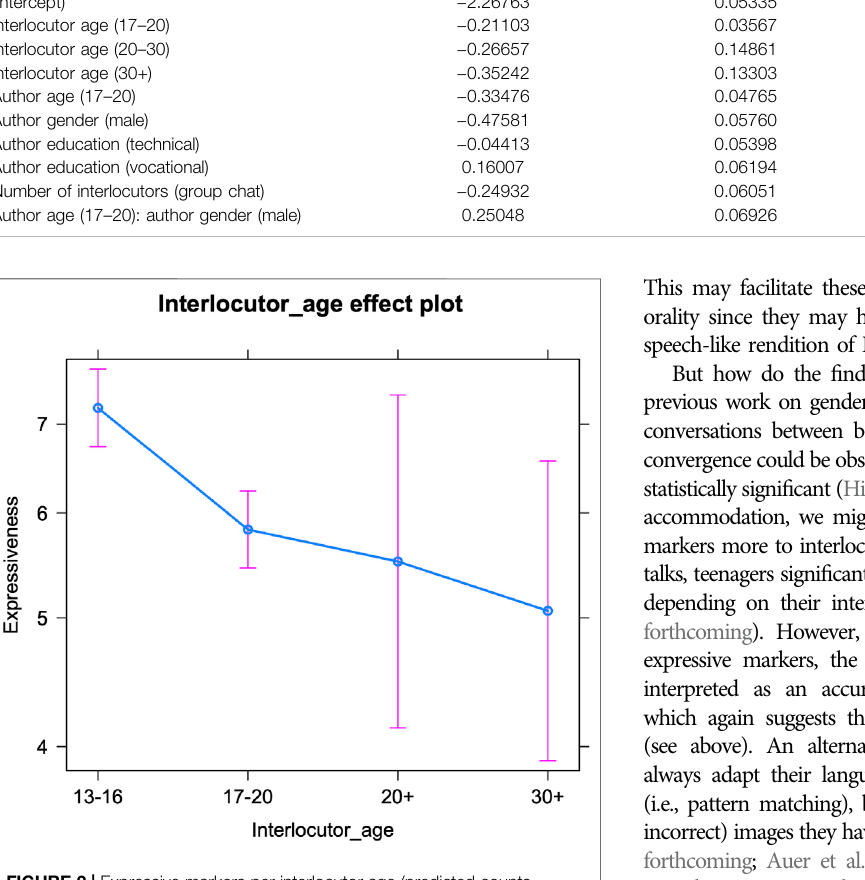
FIGURE 2 | Expressive markers per interlocutor age (predicted counts per 100